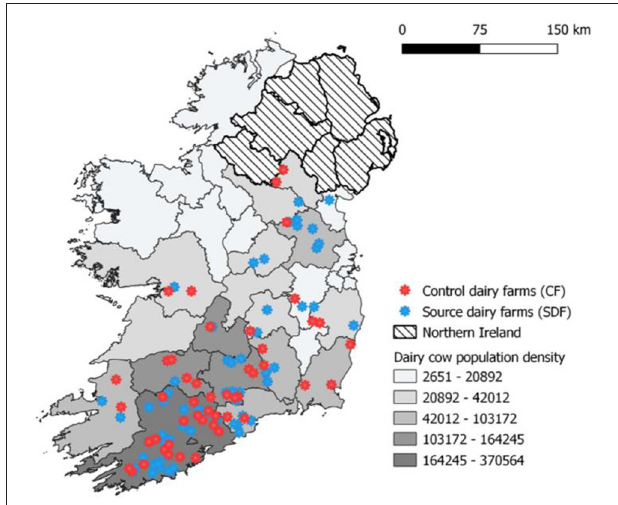
FIGURE 1 | Location of study herds and density of dairy cow population in the Republic of Ireland during